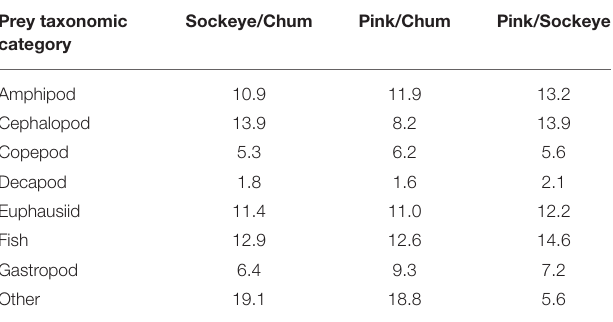
FIGURE 3 | Non-metric multidimensional scaling ordination of Bray-Curtis dissimilarities between arcsine square root transformed proportional weight/volume data for prey taxonomic classifications of chum, pink, and sockeye stomach content data. Prey taxonomic classification vectors are overlaid on the ordination to show how prey taxonomic groups relate to species differences in diet composition. Ellipses represent standard deviation. TABLE 3 | The percent contribution of prey taxonomic categories to the average Bray-Curtis dissimilarity between sockeye, pink, and chum salmon in the North Pacific Ocean, as determined by SIMPER